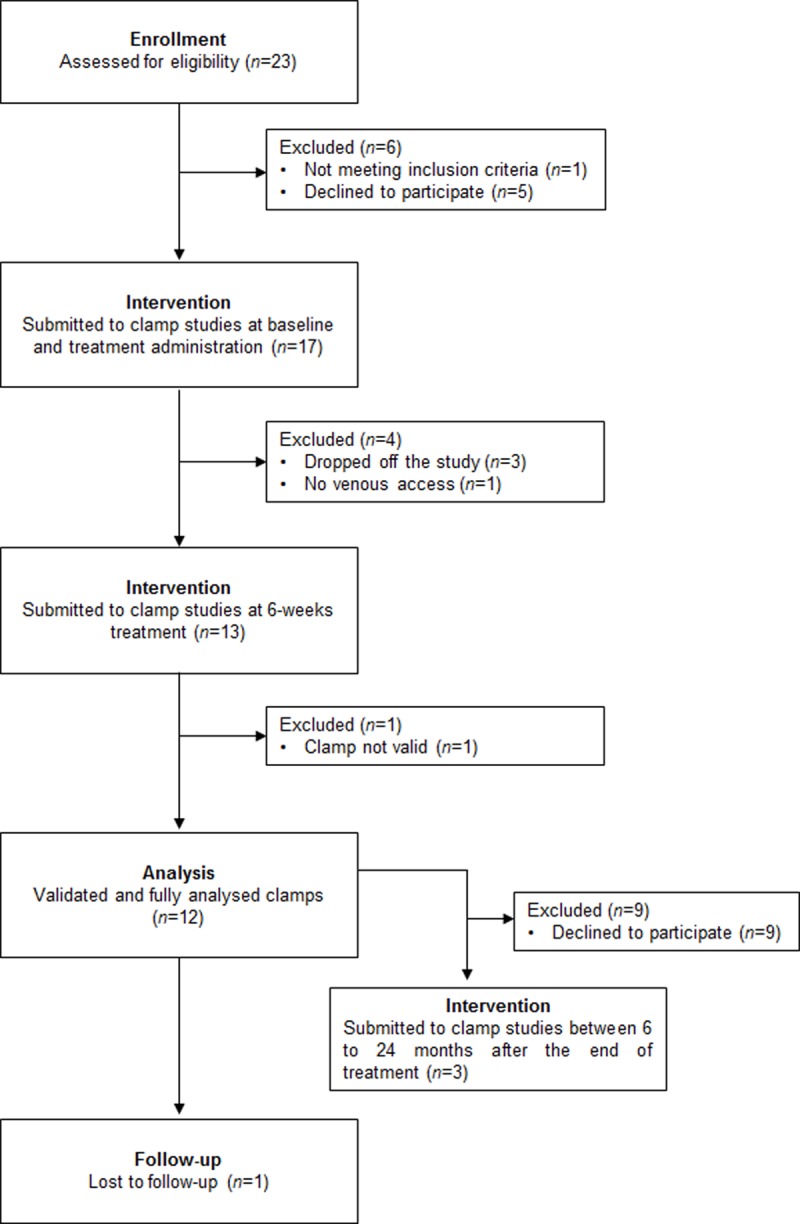
Flowchart of the study design.